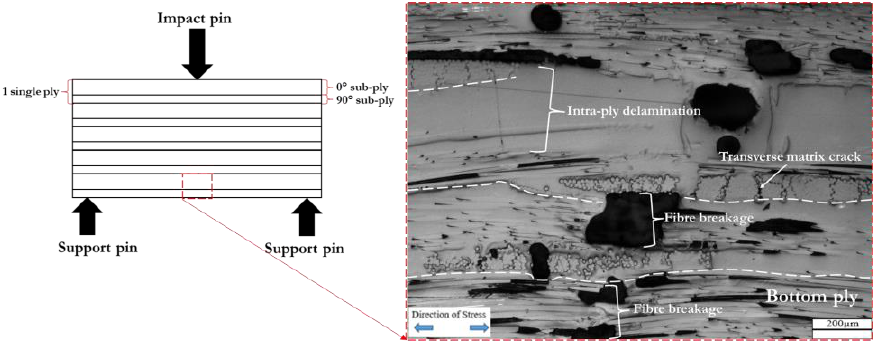
Figure 7. Typical failure modes on the tension side of a NCF basalt/epoxy composite under bending loads.